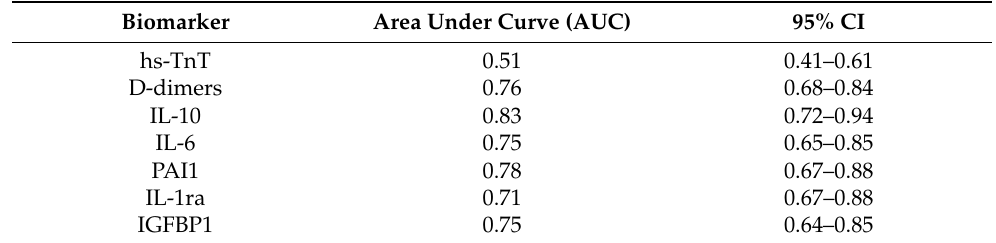
Table 4. Diagnostic performance for AAD diagnosis of selected biomarkers in the confirmatory cohort.